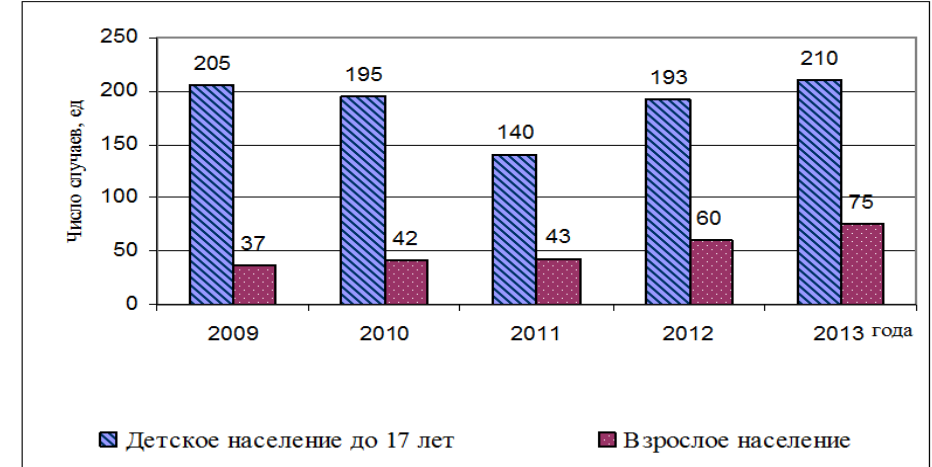
Рис 4. Динамика заболеваемости острыми кишечными инфекциями населения г. Рубцовска (2009 – 2013 гг.) Анализ заболеваемости острыми кишечными инфекциями среди детского и взрослого населения в течении пятилетнего периода, показал, что среди детского населения уровень заболеваемости более чем в 3 раза превышает таковой среди взрослого населения Подобная ситуация может быть связана с тем, что детское население более восприимчиво к различным возбудителям кишечных инфекций, а также с нарушением правил личной гигиены (Салдан, 2009). Среди взрослого населения число случаев заболеваний острыми кишечными инфекциями возрастает в 2 раза к 2013 г. по сравнению с 2009 г. (Рис. 5).